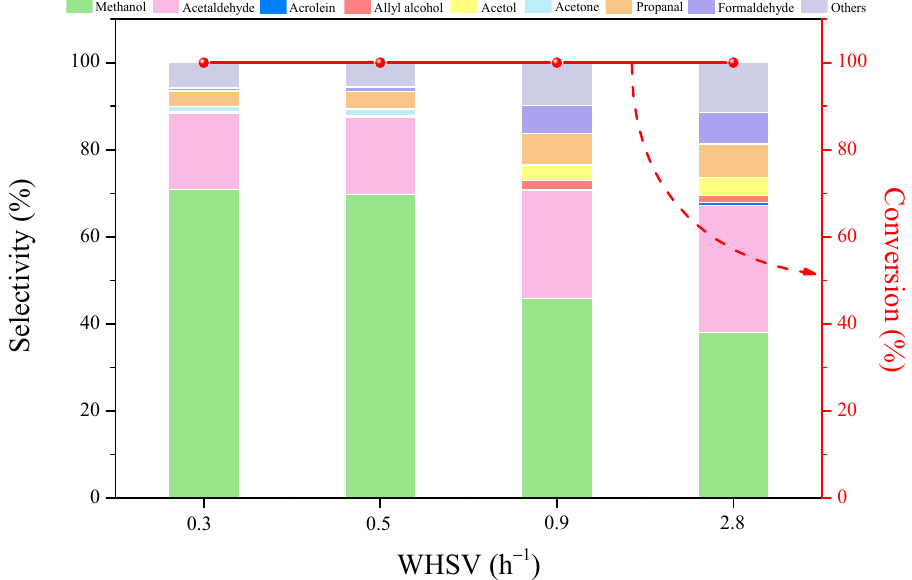
Figure 7. Glycerol conversion and products selectivity over 10%CaO/HZSM-5(38) catalysts at different WHSV. Reaction conditions: T = 340 °C, inert carrier = 20 mL min − 1 , TOS = 2 h.